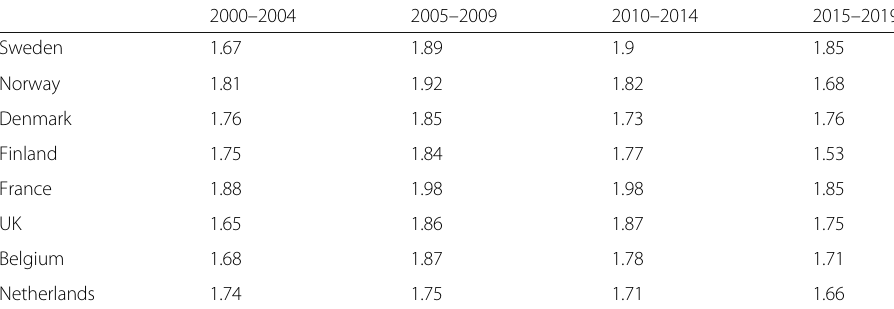
Table 2 Period total fertility rates, European cluster A countries, 2000 –